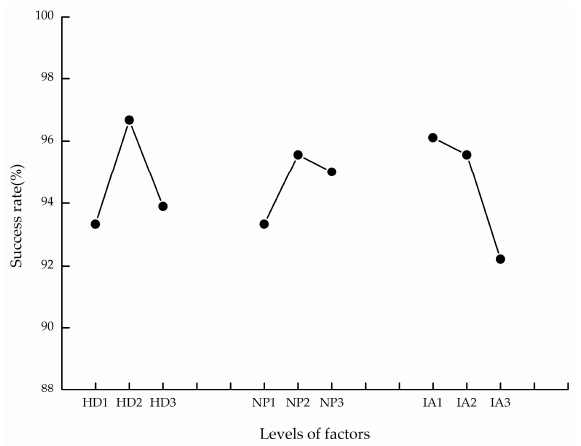
Figure 13. Comparison of effects of influencing factors on holding success